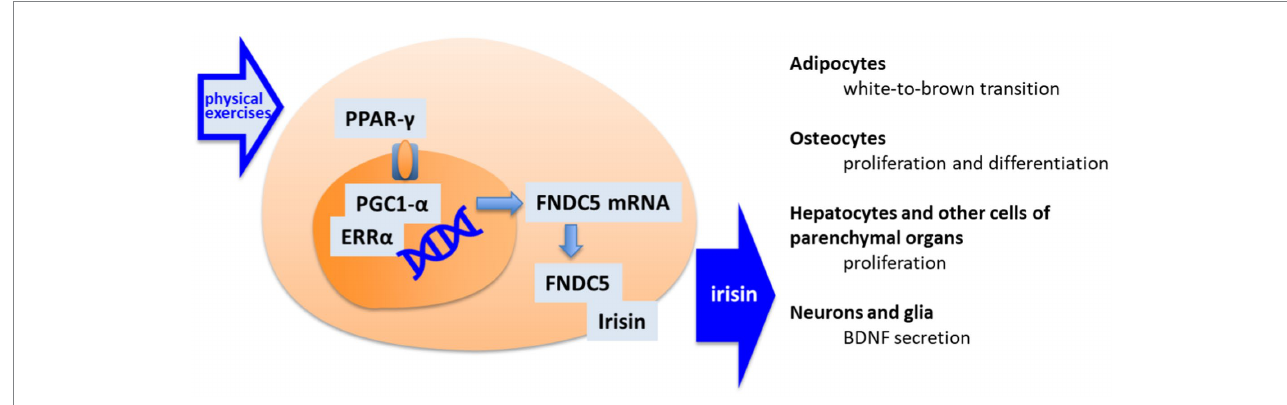
FIGURE 2 The pathway of irisin synthesis and its main cellular targets. By muscle activation, the peroxisome proliferator-activated receptor gamma (PPAR- γ ) activates the PPAR receptors by giving rise to peroxisome proliferator-activated receptor gamma coactivator 1-alpha—estrogen-related receptor alpha (PGC1- α / ERR α ) transcription factors for fibronectin type III domain-containing protein 5 (FNDC5) transcription. FNDC5 appears as precursor of irisin. Released Irisin accesses different organs, including brain, where it acts as an indirect stimulator of